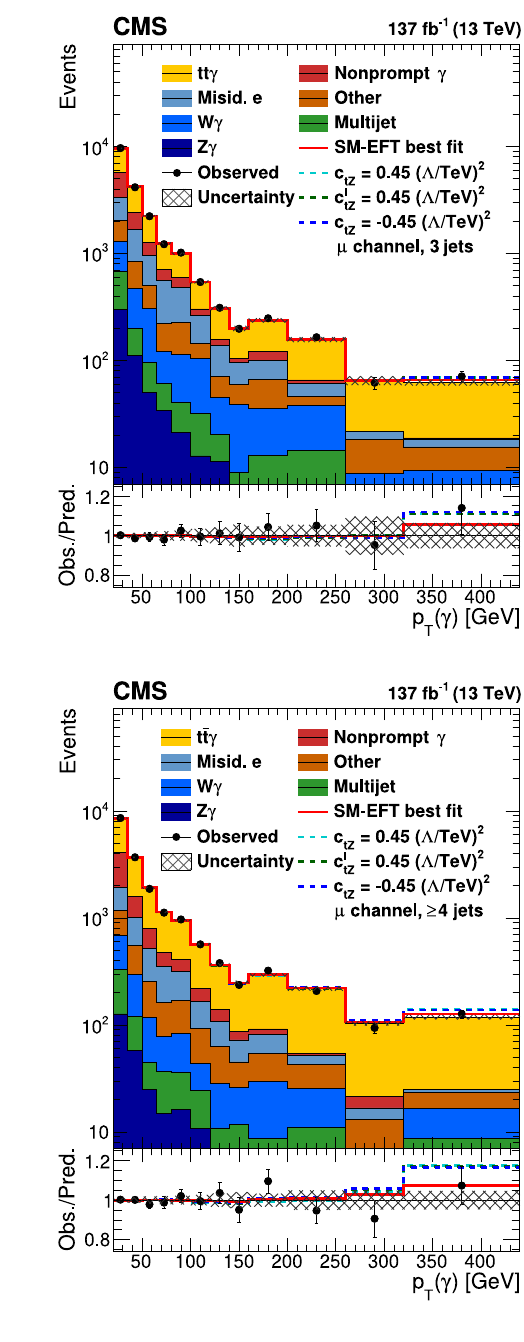
Figure 11 . The observed (points) and predicted (shaded histograms) post-fit yields for the com- bined Run 2 data set in the SR3 (upper) and SR4p (lower) signal regions for the electron (left) and muon channel (right). The vertical bars on the points give the statistical uncertainties in the data. The lower panel displays the ratio of the data to the predictions and the hatched regions show the total uncertainty. The solid line shows the SM-EFT best fit prediction and the dashed lines show different predictions for nonzero Wilson coefficients, c = − 0 . 45 (dark blue), where Λ is set to 1 c tZ